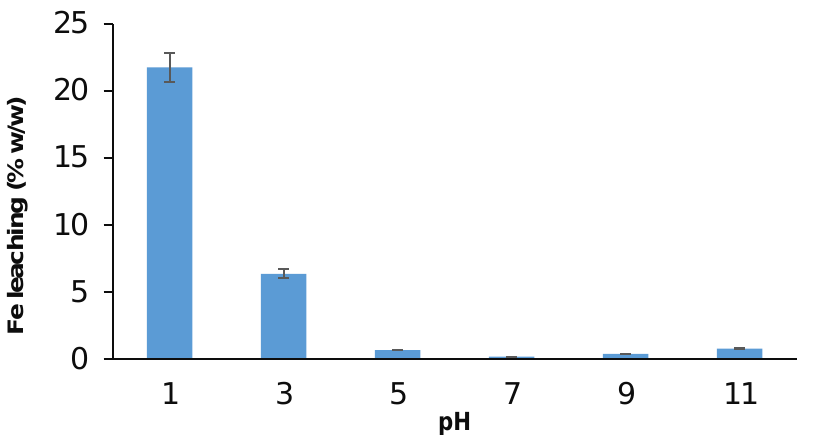
Figure 12. Leaching of iron (Fe) from microbeads at different pH values.